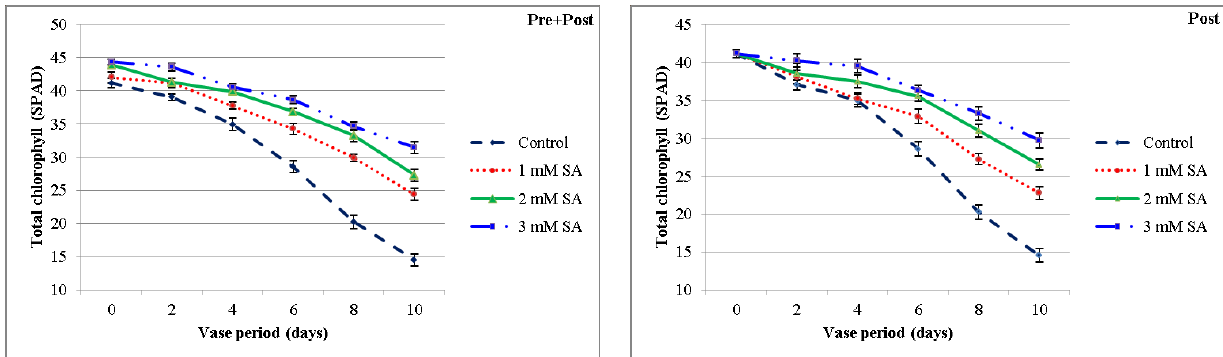
Fig. 5. Effect of pre + post-harvest and post-harvest applications of different concentrations of salicylic acid on total chlorophyll (SAPD) of cut alstroemeria flowers during vase period. The results represent the means of 12 cut flowers in 4 replicates ± standard errors